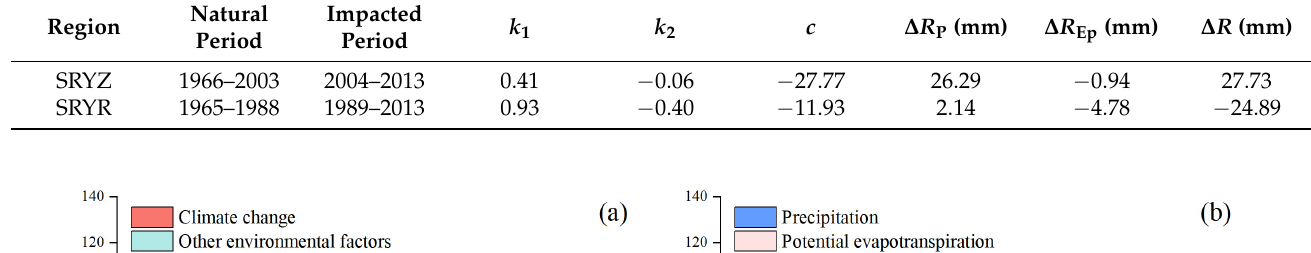
Table 2. Parameters and runoff variation calculated by the improved double mass curve method.